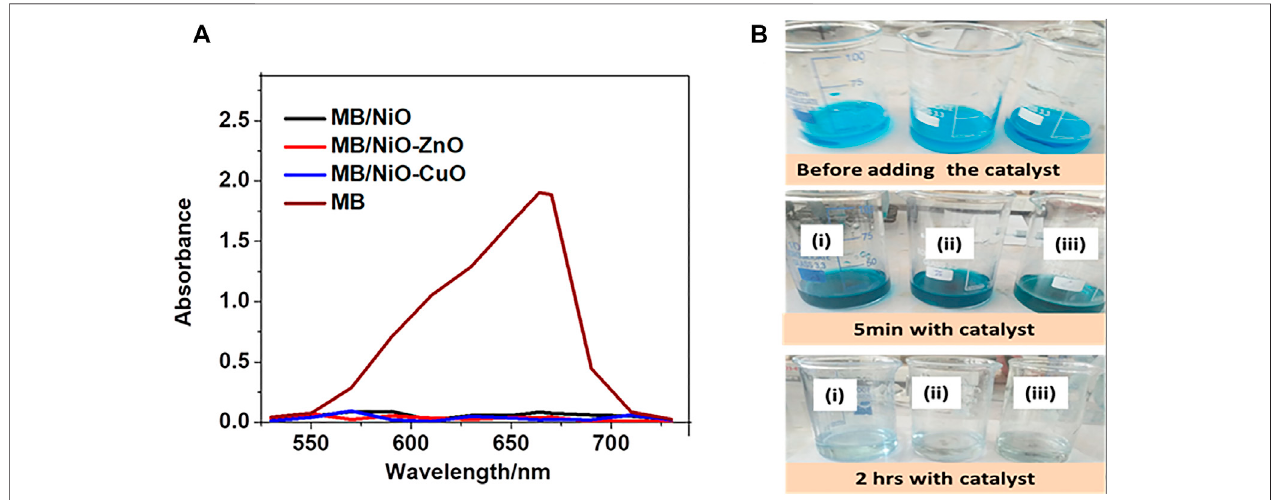
FIGURE 10 | The UV-Visible spectra of successively degraded MB in the presence of NiO, NiO-ZnO, and NiO-CuO (A) and the photograph of MB degradation: Before adding the catalyst, 5 min and 2 h later with catalysts: i. NiO, ii. NiO-ZnO, and iii. NiO-CuO (B) .